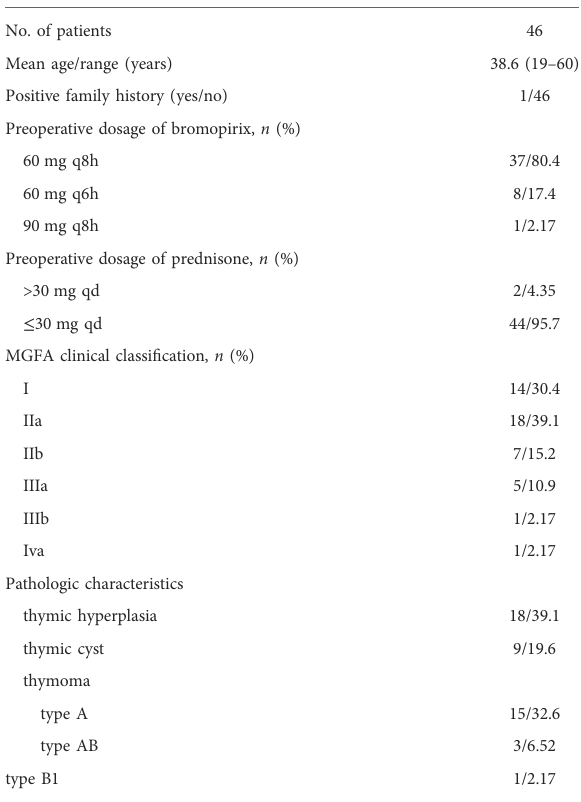
TABLE 1 Patient